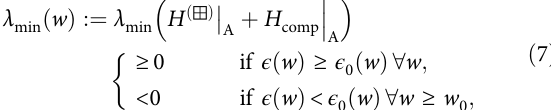
Fig. 2 The evolution of a classical TM can be represented by Wang tiles, where colours of adjacent tiles have to match, and arrowheads have to meet arrow tails of the appropriate kind. Here, the evolution runs from the bottom of the square to the top, where it places a marker (cid:129) on the boundary as explained in section ‘ Classical tiling with quantum overlay ’ . In this image, the TM ’ s evolution is contained in an individual square in the checkerboard grid shown in the fi gure